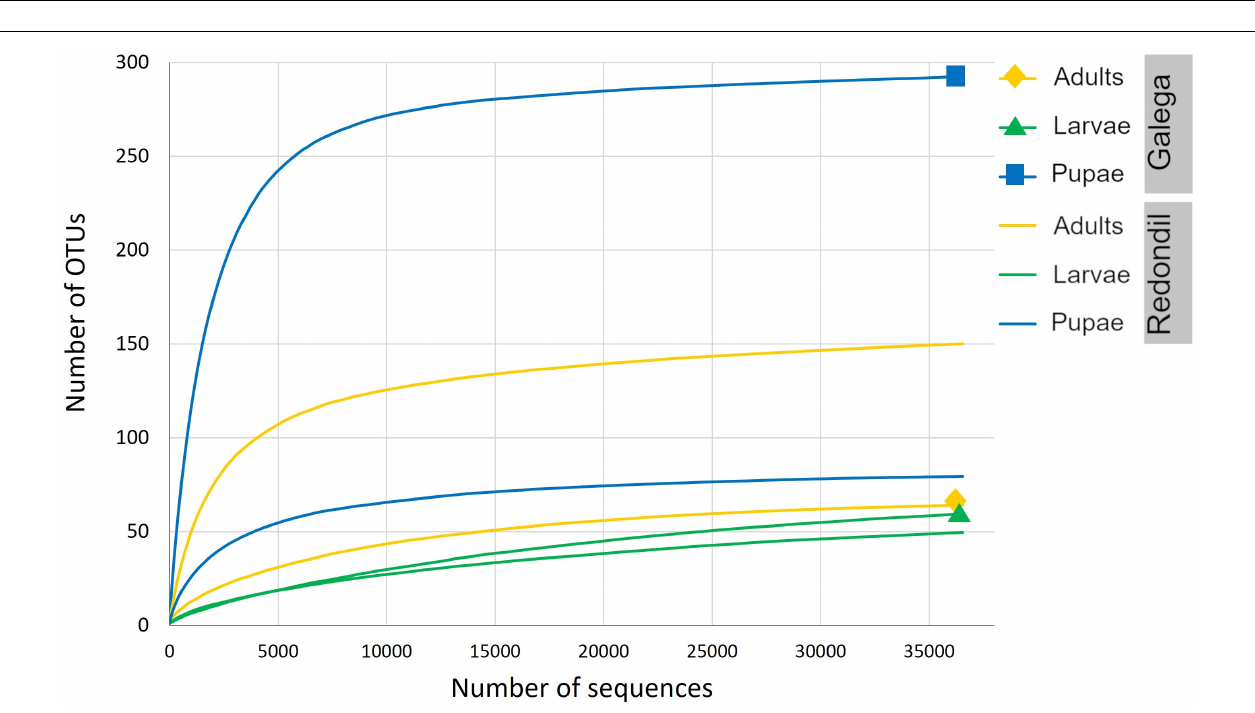
FIGURE 2 | Rarefaction curves showing the number of bacterial OTUs for each sample, defined at the 97% sequence similarity cutoff in mothur, relative to the number of total sequences.